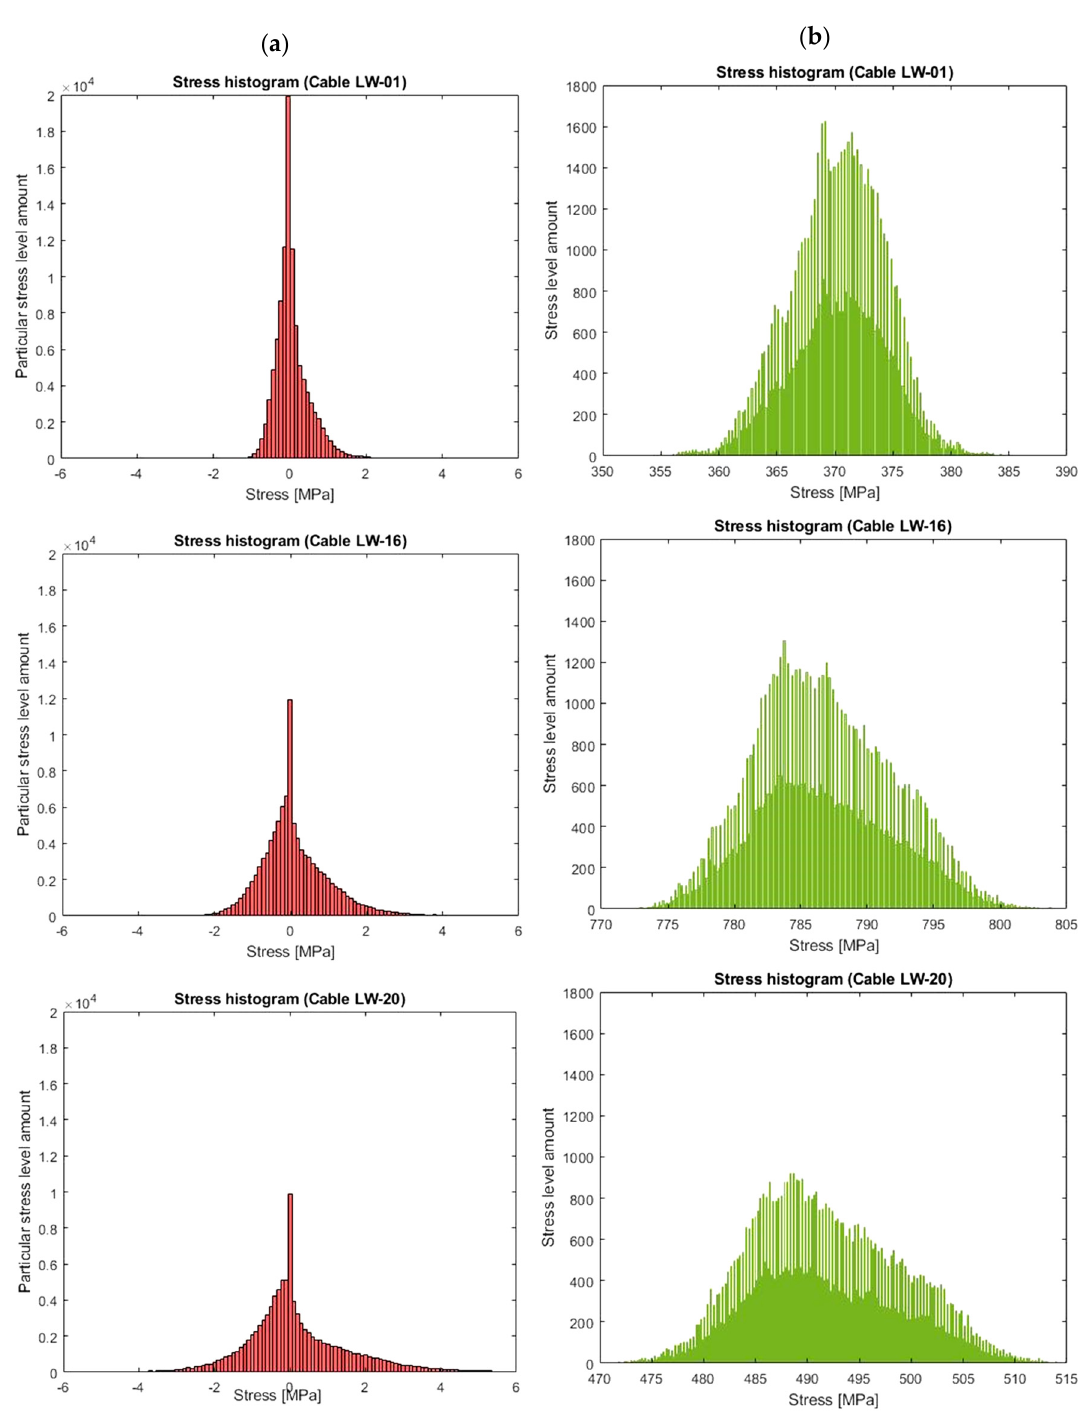
Figure 17. ( a ) Histograms of stress changes.; ( b ) amplitude histograms without separated temperature influences. At this point, Formulas (7) and (8) should be interpreted. Based on the Formula (6), parameter n i was omitted. This procedure is allowed due to the fact that n i is a constant value resulting from the i-th interval directly from the Wöhler curve. The magnitude of (cid:2026) (cid:3028),(cid:3036) is the amplitude of one complete symmetric cycle of change in stress, calculated with the rain-flow procedure. These are values greater than zero. Coefficient D s contains stress |(cid:2026) | oscillations around the average value. Due to the method adopted here, this value is (cid:3046),(cid:3036) 0, and therefore the fluctuations are negative and positive. They can be treated as sepa-